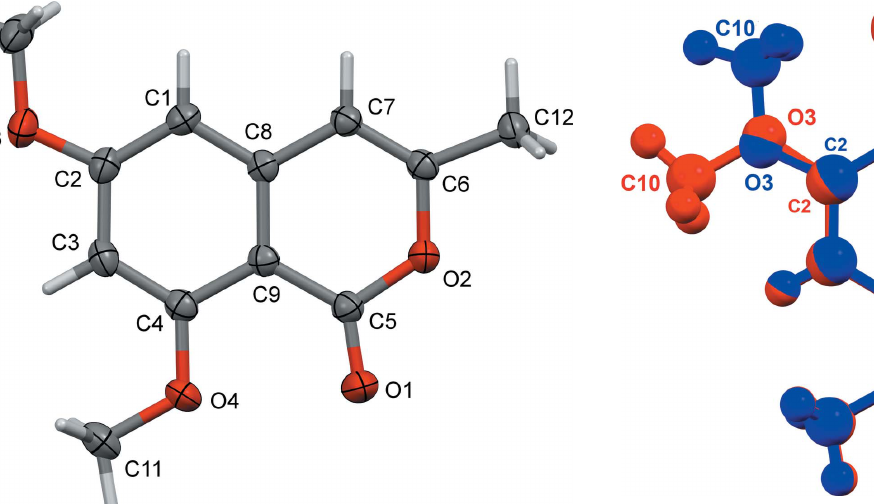
Figure 1 The molecular structure of compound I , with atom labelling. Displace- ment ellipsoids are drawn at the 50% probability level.